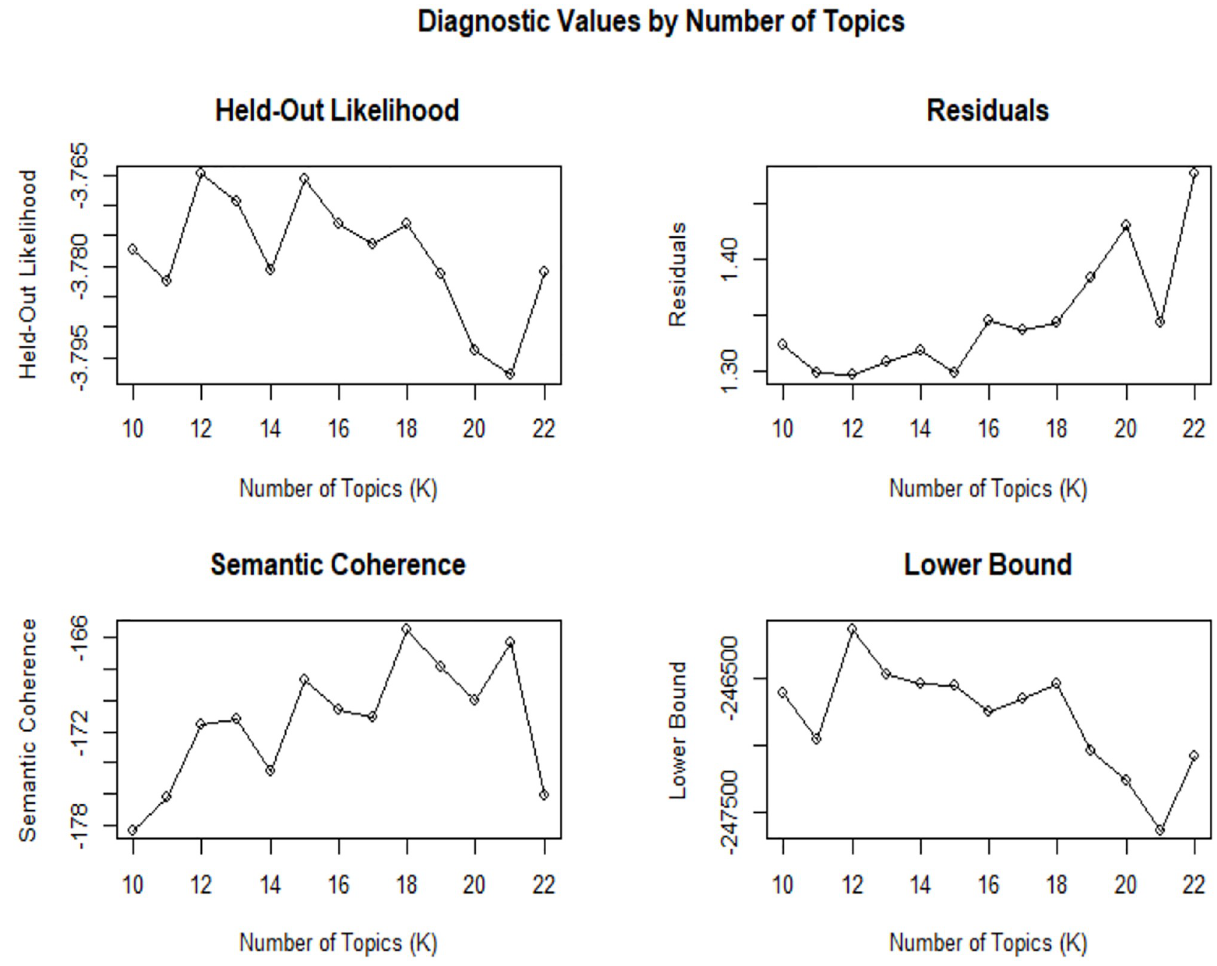
Fig 2. Run results of search K